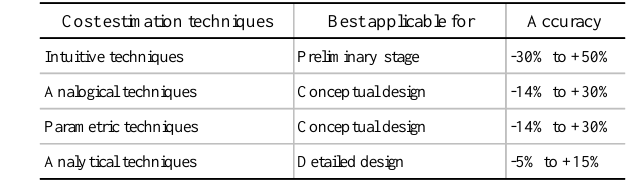
Fig. 3: Accuracy of the cost estimation techniques, adapted from [3,21] Figure 3: Accuracy of the cost estimation techniques, adapted from [3, 21].